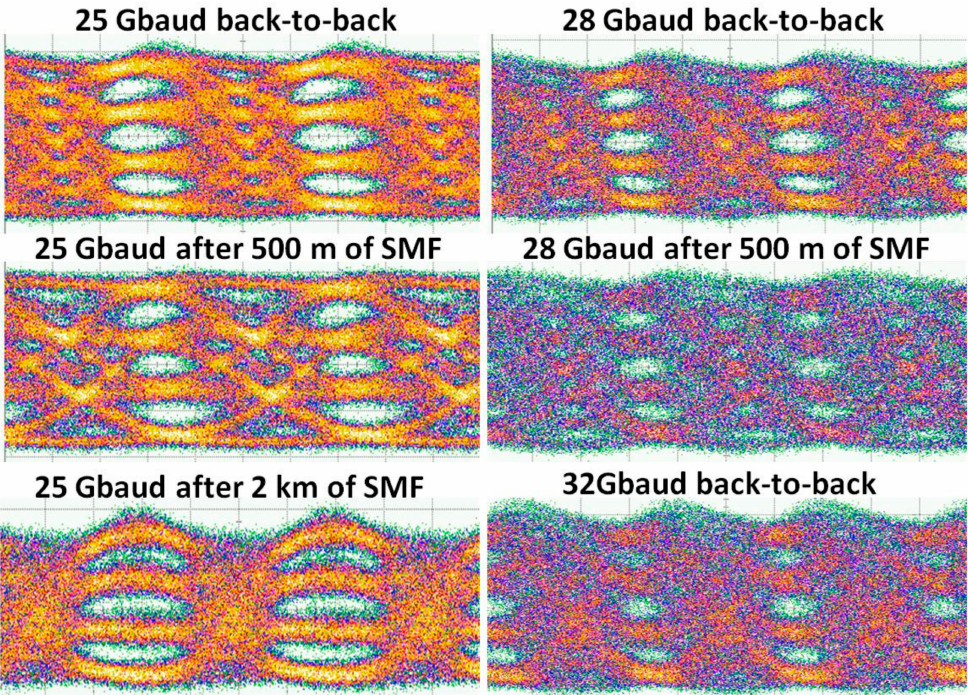
Figure 8. PAM-4 optical eye diagrams at the output of the linear receiver at 25, 28, and 32 Gbaud for back-to-back configuration and propagation in 500 m and 2 km of